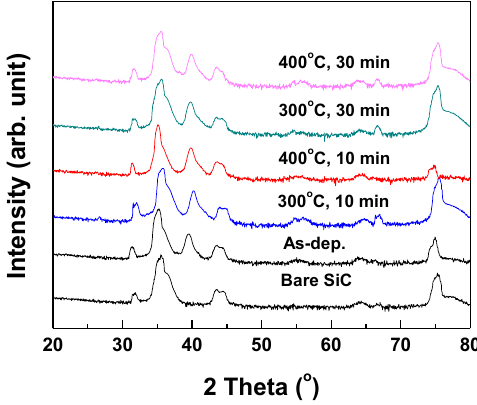
Figure 7. XRD patterns of the Mo/SiC Schottky contact.